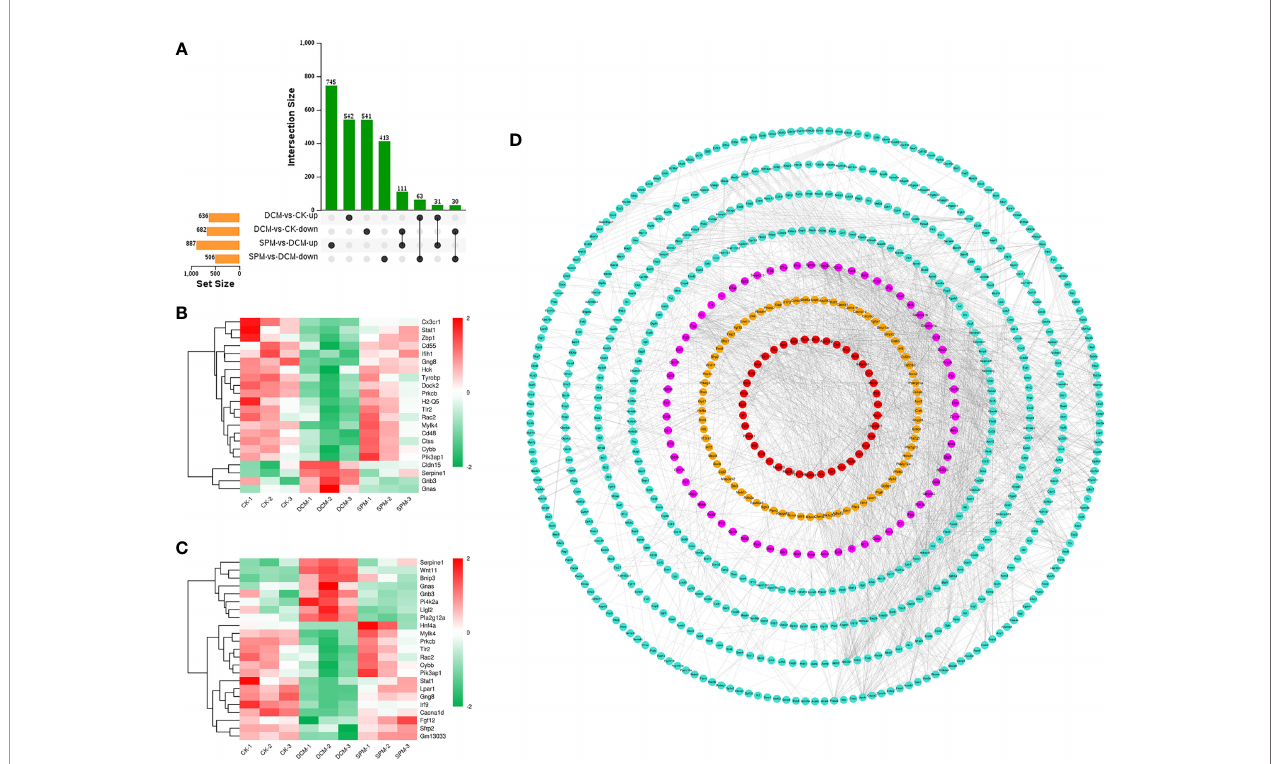
FIGURE 3 | SPM reduces DCM myocardial damage by regulating immunity and signal-transduction-related pathways. (A) UpSet Venn diagram shows the number of overlap genes that up- or down-regulated in DCM and reversed by SPM. Heat map shows the hierarchical clustering of overlap genes in (B) immunity-related pathways or (C) signal transduction pathway. Red color shows the genes with signi fi cantly elevated transcription levels, and green color shows the genes with signi fi cantly reduced transcription levels. (D) Gene interaction network analysis of immunity and signal transduction pathways related candidates between SPM and DCM. Immunity and signal transduction pathways related candidates are colored in pink, yellow, or red, and other genes are colored in